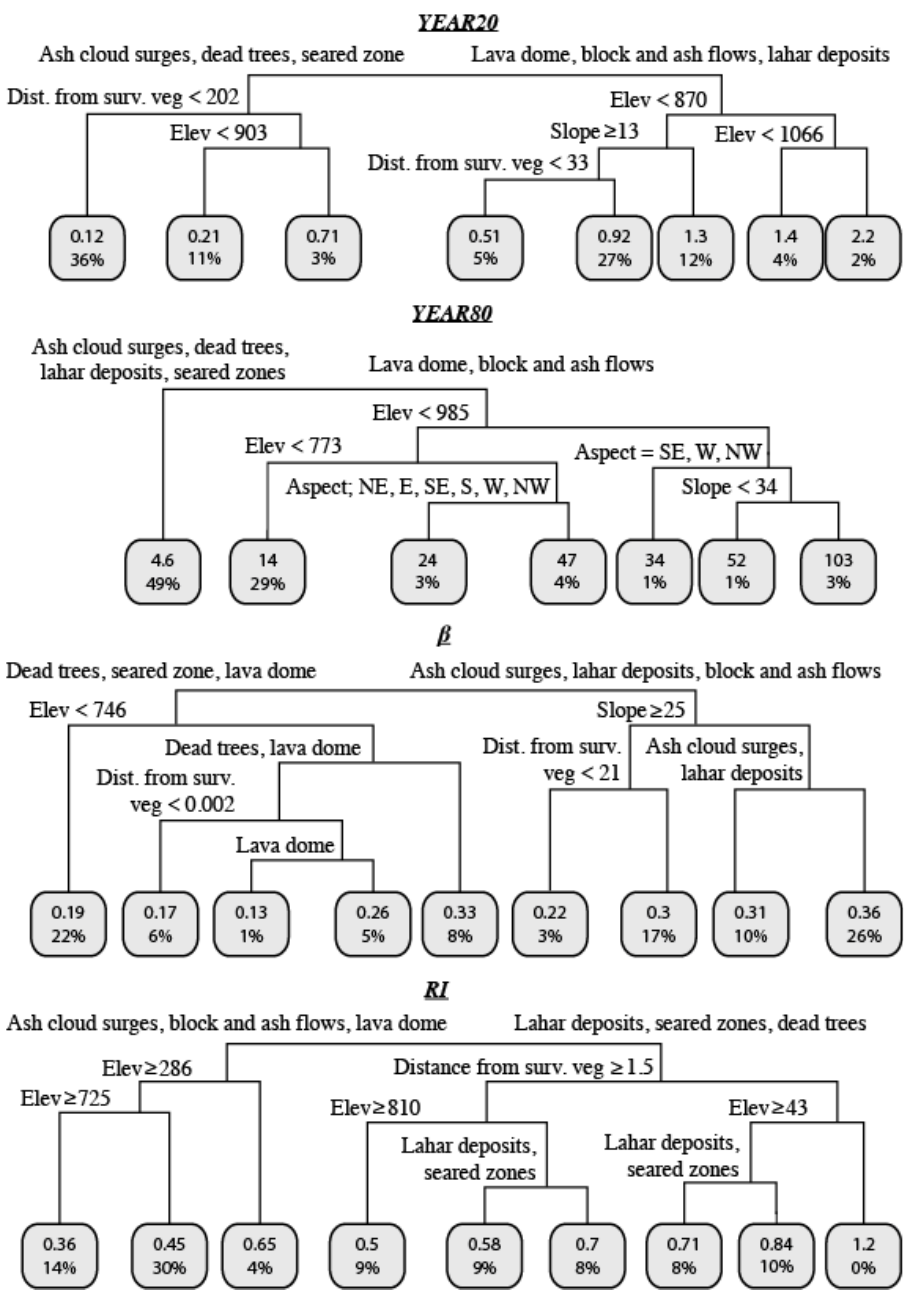
Figure 8. Regression tree results for each recovery metric.